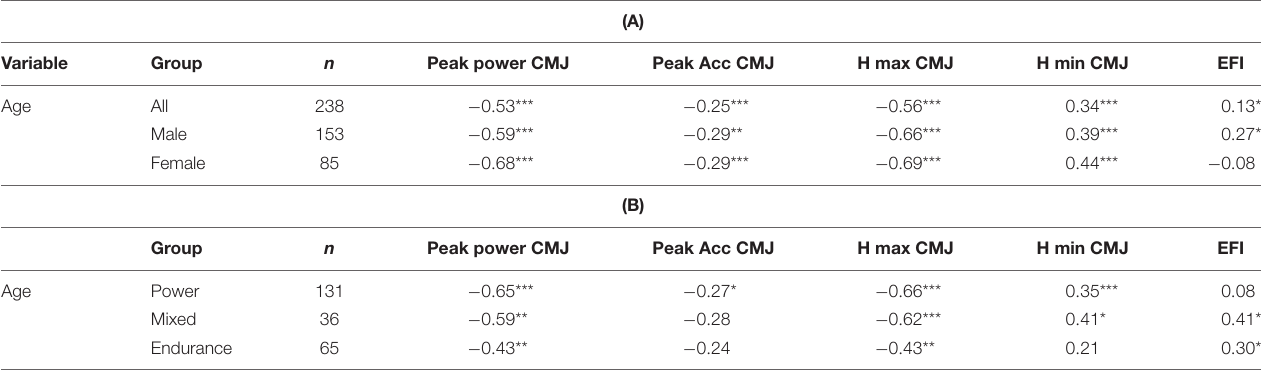
TABLE 3 | (A) Spearman’s rank correlation coefficients between age and vertical jump performance stratified by sex. (B) Spearman’s rank correlation coefficients between age and vertical jump performance stratified by athletic specialty.